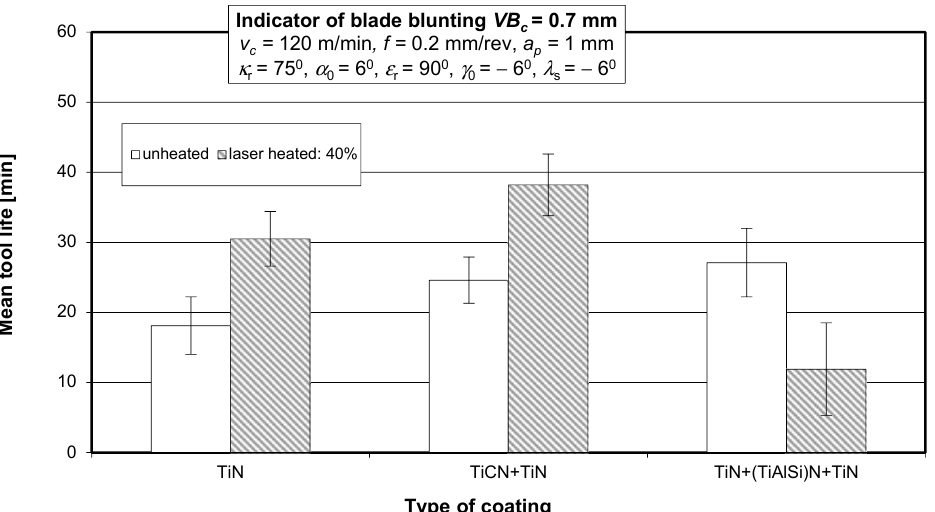
Figure 13. Mean life of the SM25 sintered carbide cutting tool blades coated with TiN, TiCN + TiN, and TiN + (TiAlSi)N + TiN before and after laser heating with 40% of the maximum laser power, obtained in a turning process of 35HGS alloy steel.